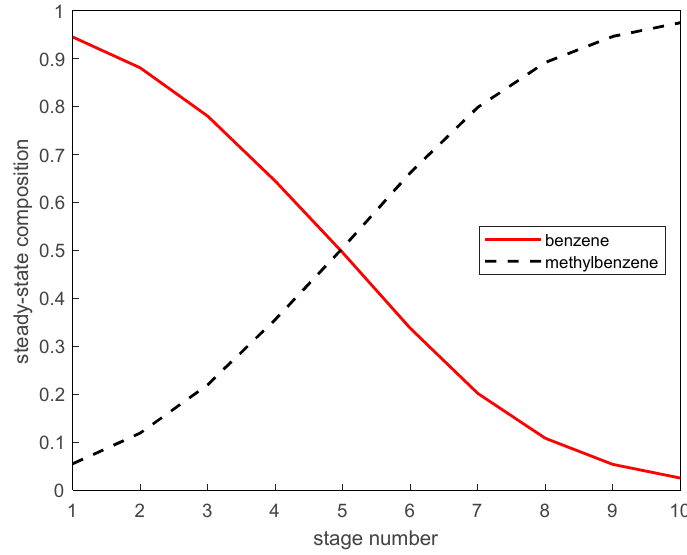
Figure 6. Concentration distribution curve of distillation column in steady state.